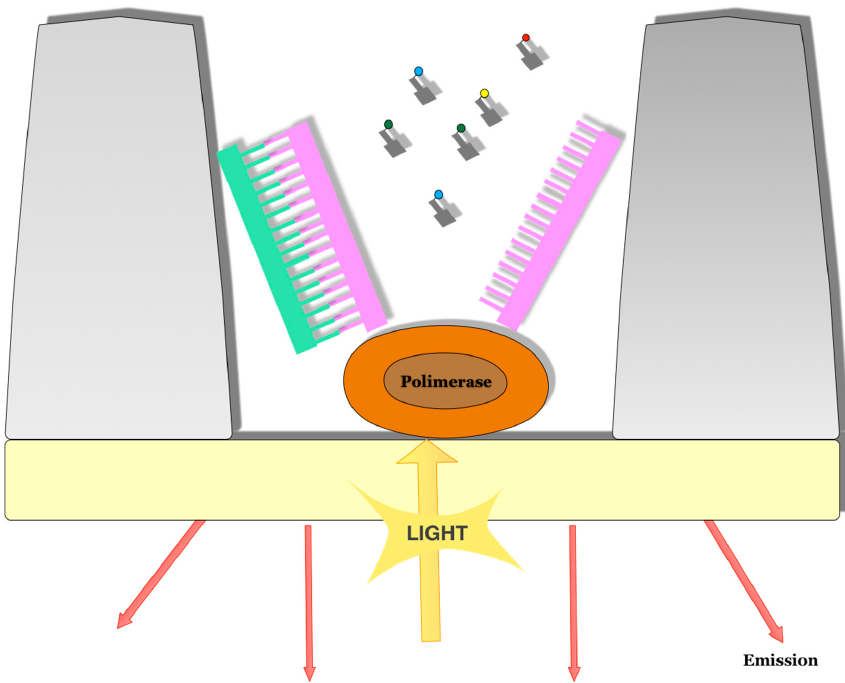
Figure 11. Polymerase fixed to the bottom of an individual well. In the Pacific Bioscience platform, the DNA moves generate signals because of the incorporation of phosphate-labeled nucleotides.